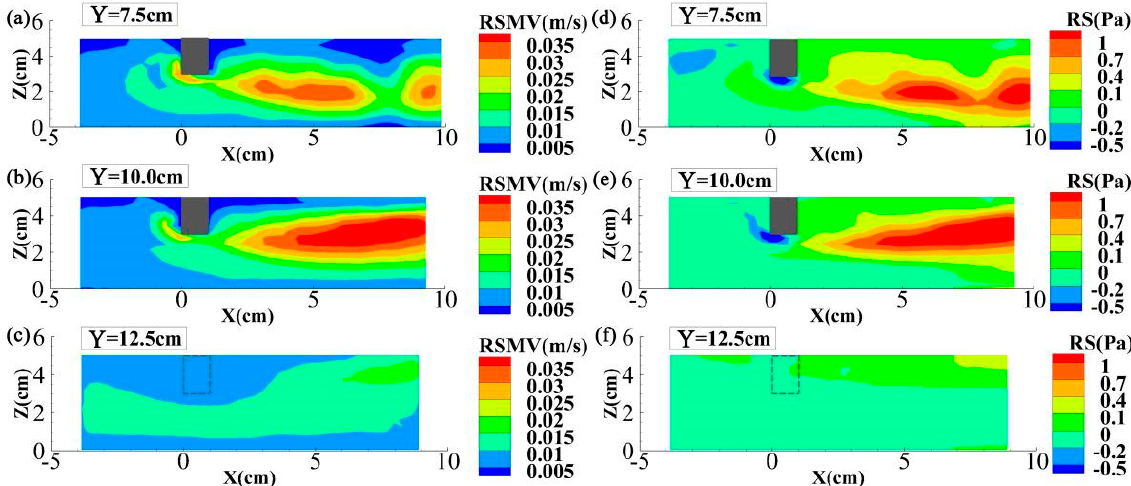
Figure 6. Distributions of the absolute velocity at longitudinal sections ( a ) Y = 2.5 cm, ( b ) Y = 5.0 cm, ( c ) Y = 7.5 cm, ( d ) Y = 10.0 cm, ( e ) Y = 12.5 cm, ( f ) Y = 15.0 cm, ( g ) Y = 17.5 cm, ( h ) Y = 20.0 cm, ( i ) Y = 22.5 cm, and ( j ) Y = 27.5 cm in Case 2. The grey areas in subfigures ( a ) to ( d ) demonstrate the floating dike, and the dotted lines in subfigures ( e ) to ( j ) indicate the location of floating dike in the coordinate system.